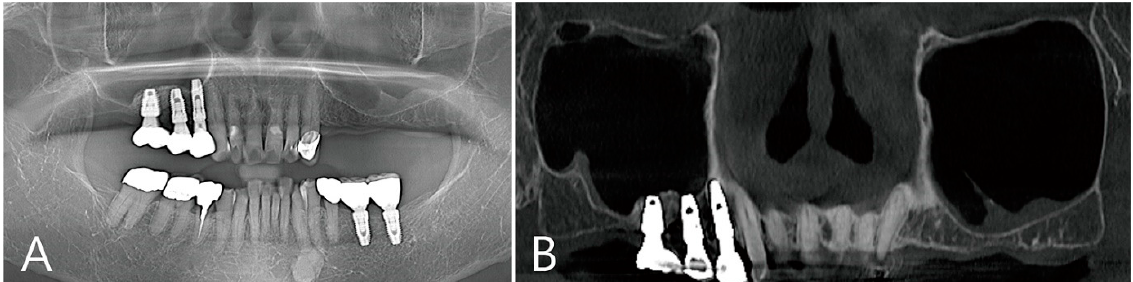
Figure 10. Case 4. Preoperative panoramic radiography and CBCT scan were performed: ( A ) the left maxillary sinus was severely pneumatized and had minimal residual bone height; ( B ) in the left maxillary sinus, membrane thickening was confined to the sinus floor and no sinus pathology was observed in the remaining